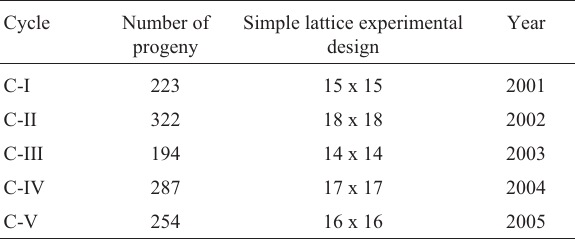
Table 1 - Number of S 0:1 progenies from each cycle of the recurrent selection program, experimental design, plot size and sown date. The plot